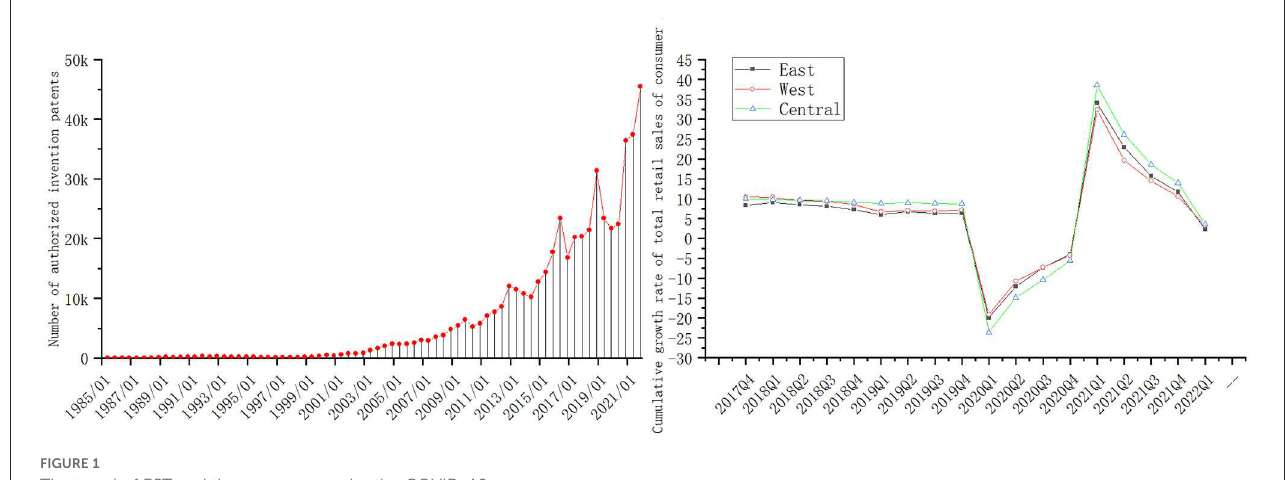
FIGURE1 The trend of EST and the economy under the